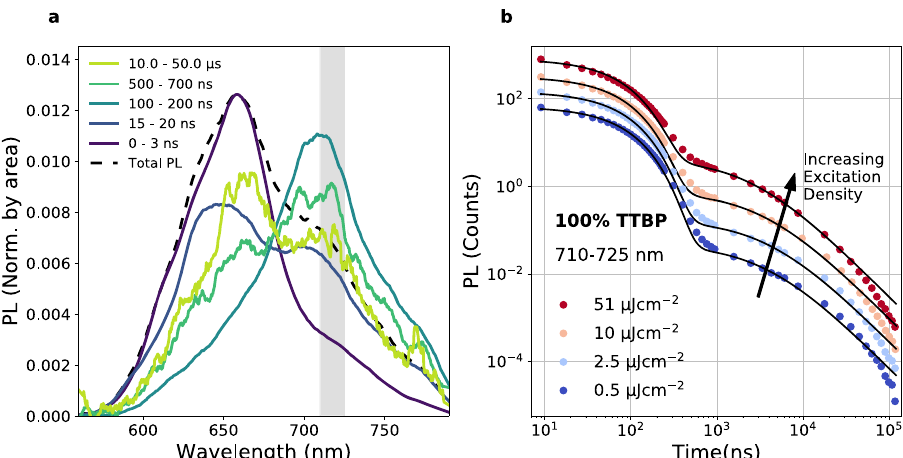
Fig. 4 Time-resolved PL of TTBP. a Time-cuts of time-resolved photoluminescence for a 100% TTBP dropcast fi lm at room temperature with an excitation fl uence of 25 µ J cm − 2 , showing the early dominance of the 660 nm peak, followed by a red-shift to 720nm over ~30 ns, followed by a shift back to 660 nm after ~500 ns. Grey bar indicates wavelength range in b . b Filled circles indicate PL signal integrated over the wavelength range indicated in grey in a with varied fl uence. A relative increase in the delayed photoluminescence (after 500 ns) is seen as excitation density increases. Solid lines are fi ts consisting of the sum of a monomolecular decay ( τ ~ 65 ns) and a bimolecular decay at later times (see Supplementary Note 2 for